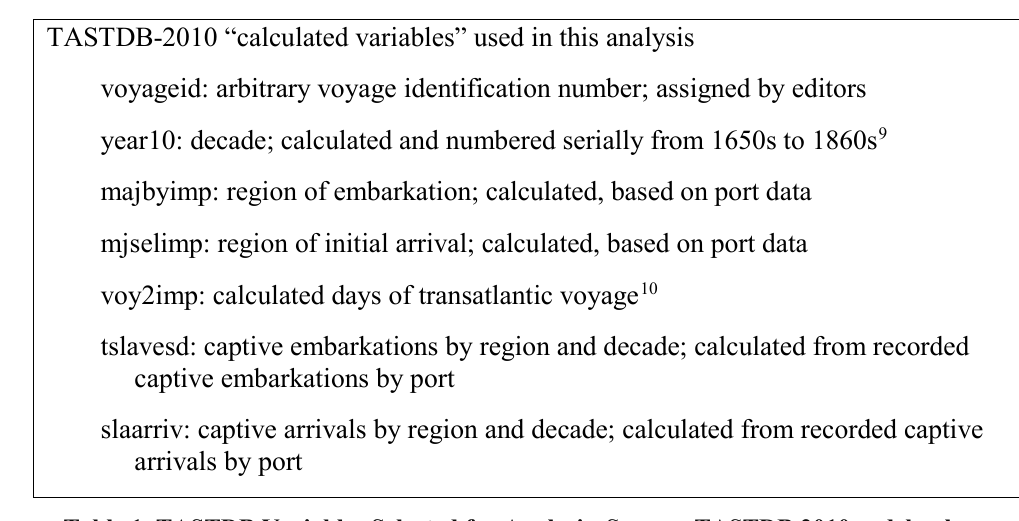
Table 1. TASTDB Variables Selected for Analysis. Source: TASTDB 2010 codebook.